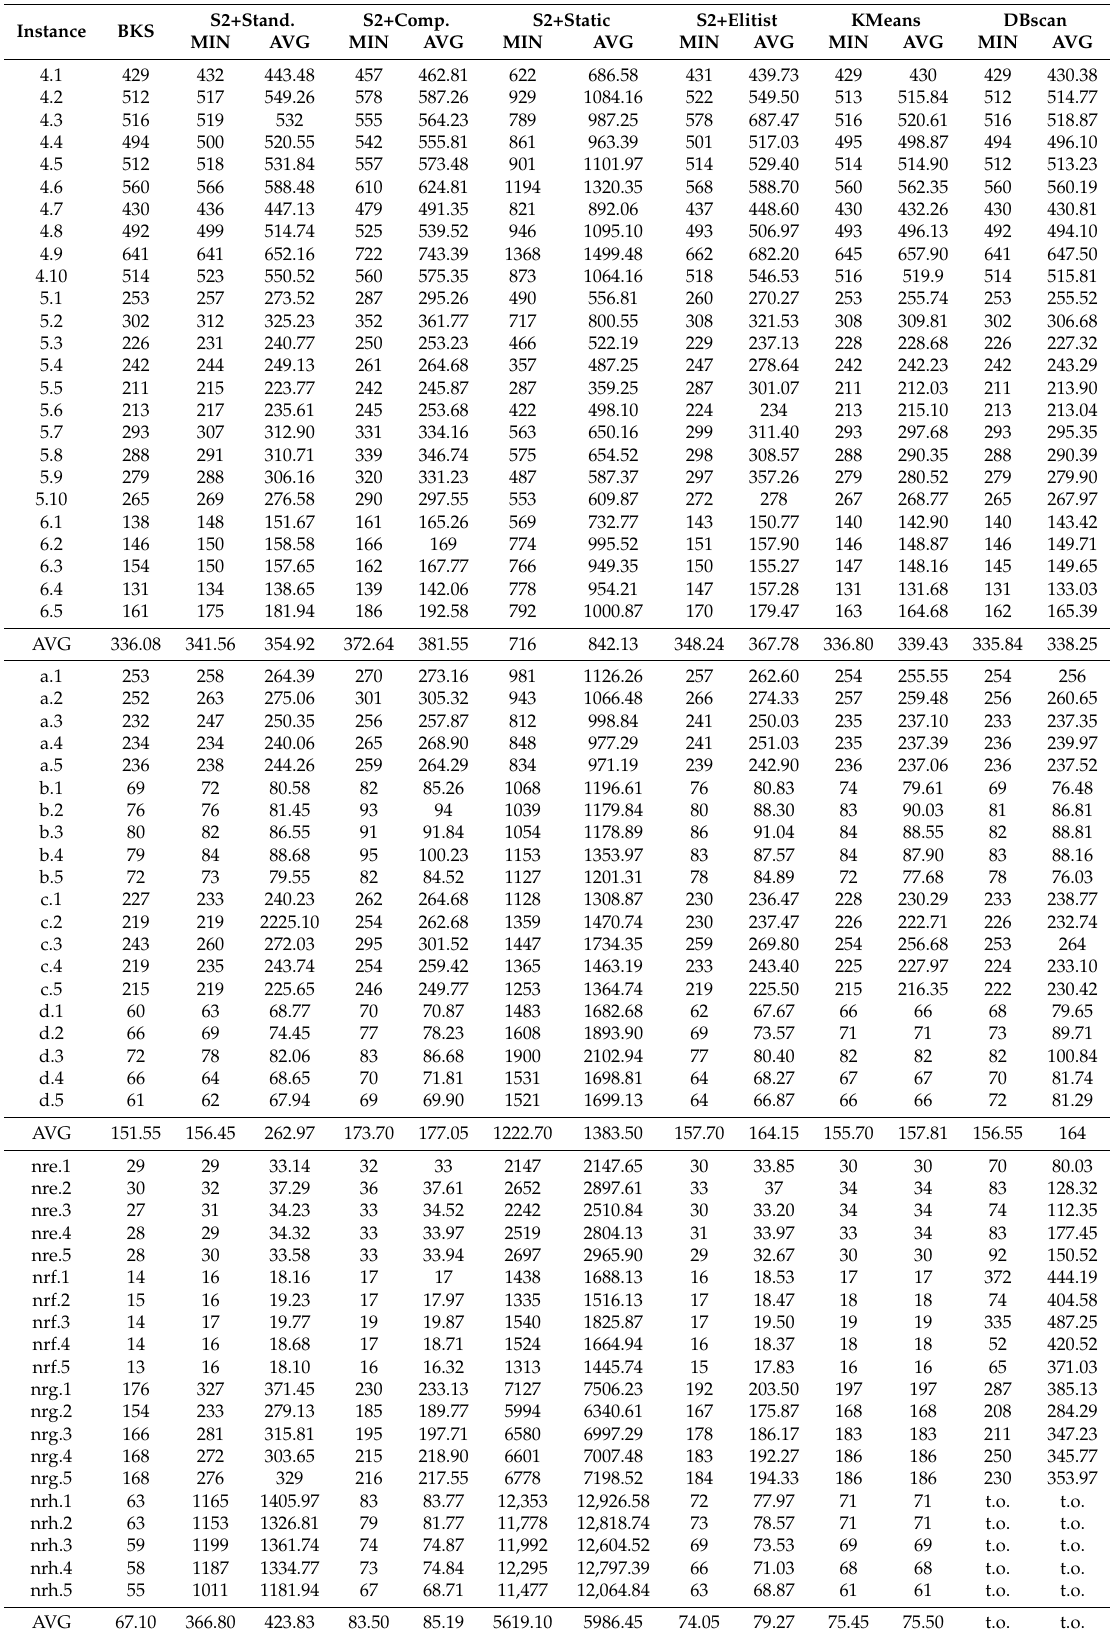
Table A2. CSA/SCP—SShape 2—Two-steps vs. KMeans vs. DBscan (t.o = time